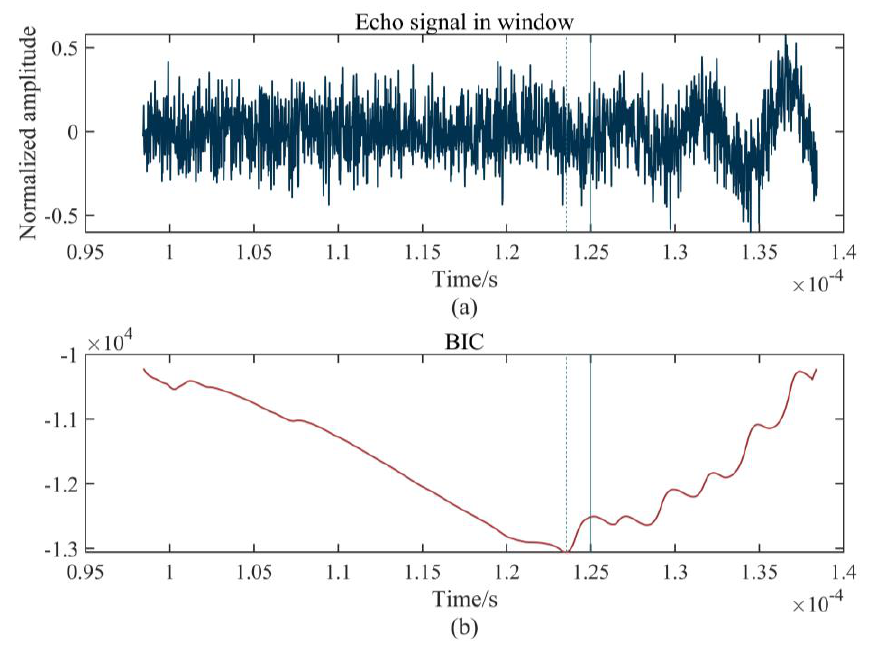
Figure 4. Time-frequency distribution based on MWT: ( a ) time window; ( b ) BIC function.